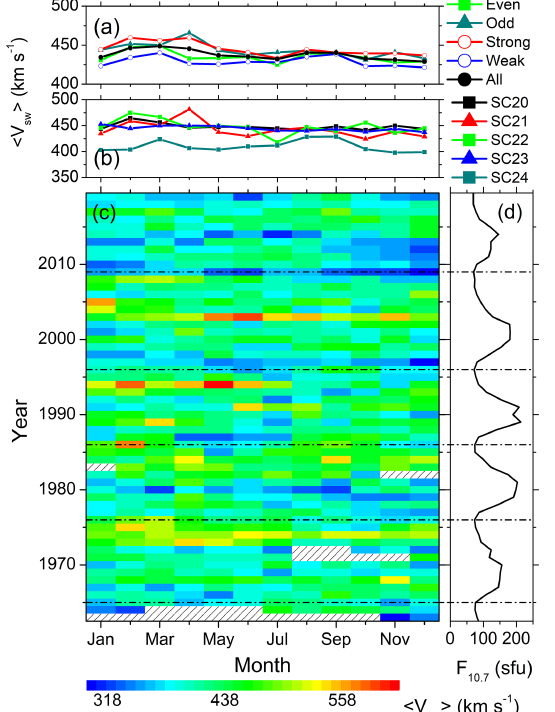
Figure 10. Solar wind speed V sw variation from 1963 to 2019. The panels are in the same format as in Fig. 7.